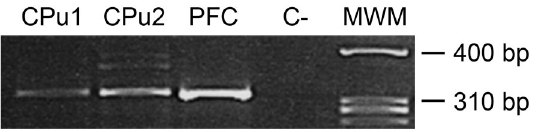
Figure 1. Dopamine D 4 R mRNA expression in the caudate putamen. Expression of transcripts encoding the dopamine D 4 R was analyzed regionally in the caudate putamen (CPu) from two pools (n = 3 each) and prefrontal cortex (PFC) from one pool (n = 3) of control animals. No signal was detected in the sample run without RNA sample (C −